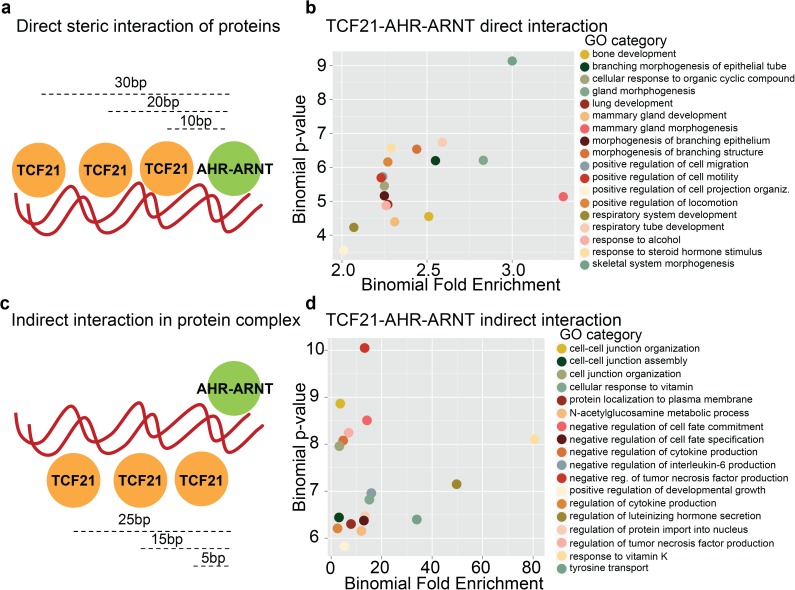
Rotational phasing of PWM predicts steric interaction of TCF21 and AHR differentially regulates transcriptional programs.(a) Schematic representation of rotationally phased TCF21 and AHR spaced at n(10bp) distances along the DNA indicating direct interaction between proteins. (b) GO terms enriched in genes proximal to rotationally phased TCF12, employed here as surrogate for TCF21, and AHR-ARNT JASPAR matrices. (c) Schematic of rotationally unphased TCF21 and AHR proteins spaced at 5bp+n(10bp) distances indicating indirect interaction through an intermediary protein or a protein complex. (d) GO terms enriched in genes proximal to rotationally unphased TCF12 and AHR-ARNT JASPAR matrices.